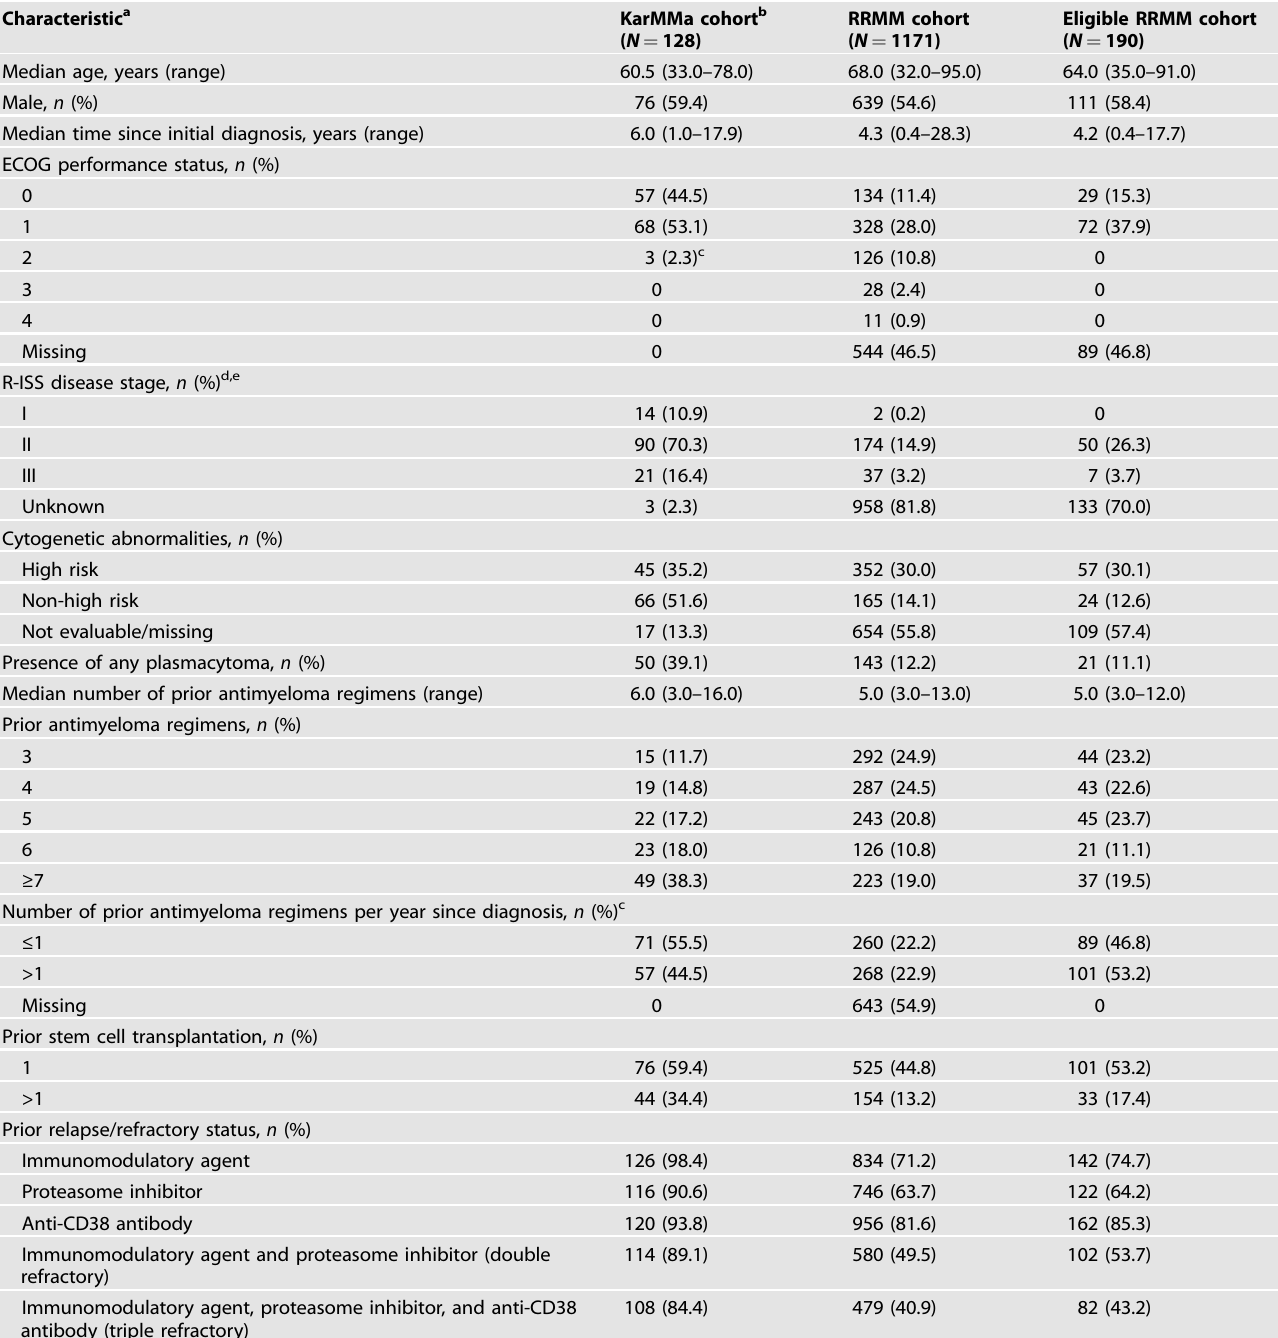
Table 1. Baseline demographics and disease characteristics (RRMM, Eligible RRMM,